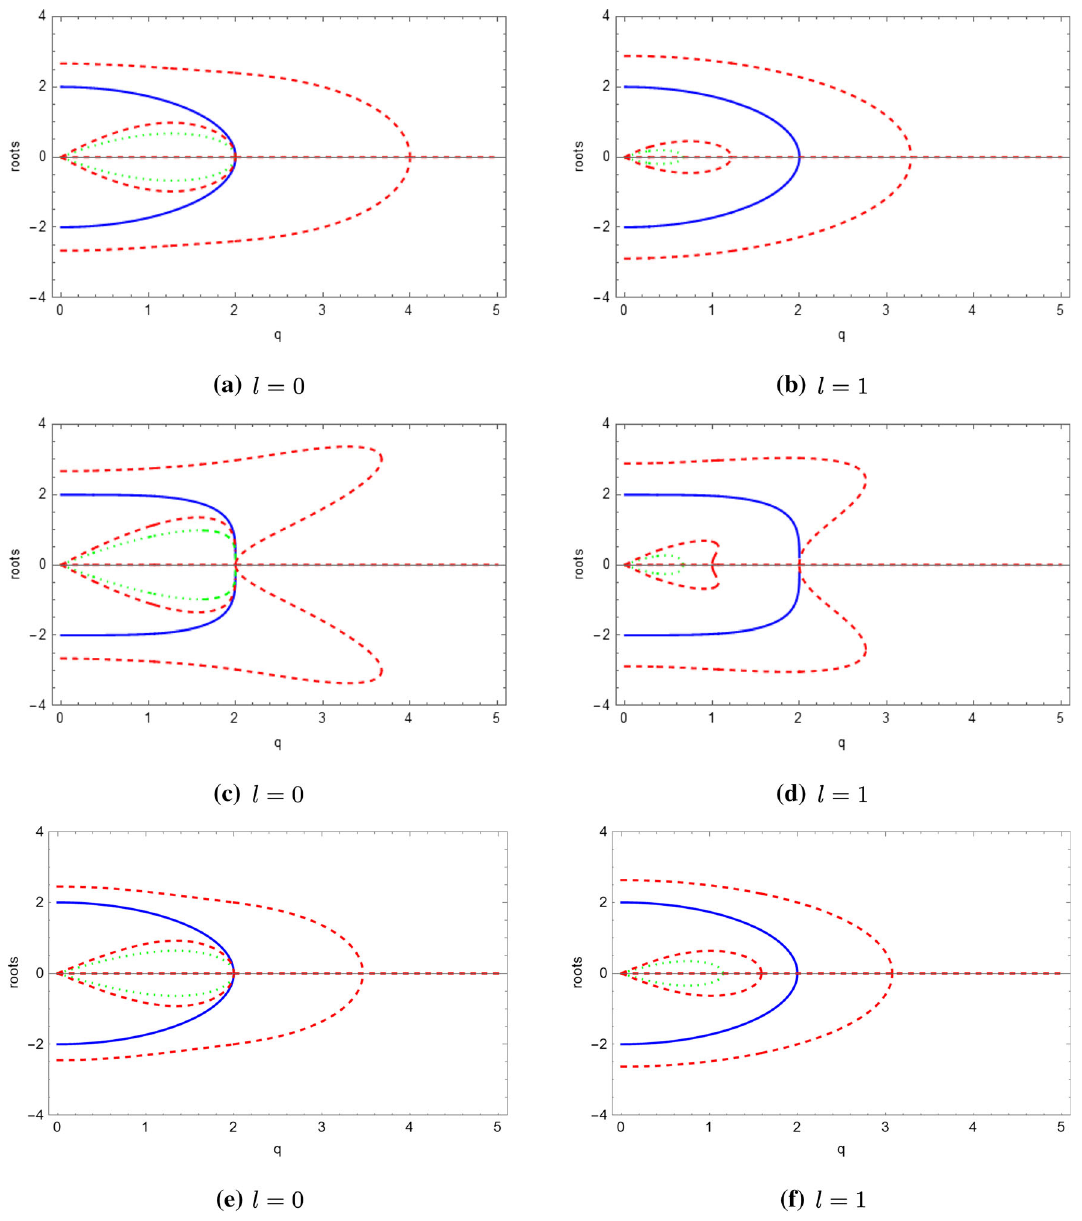
Fig. 1 Roots of (24) (blue solid line), (25) (green dotted line) and (26)(red dashed line) of the three symmetric metrics. From top to bot- tom, they correspond to the SV metric, the LRSSV metric and the HY